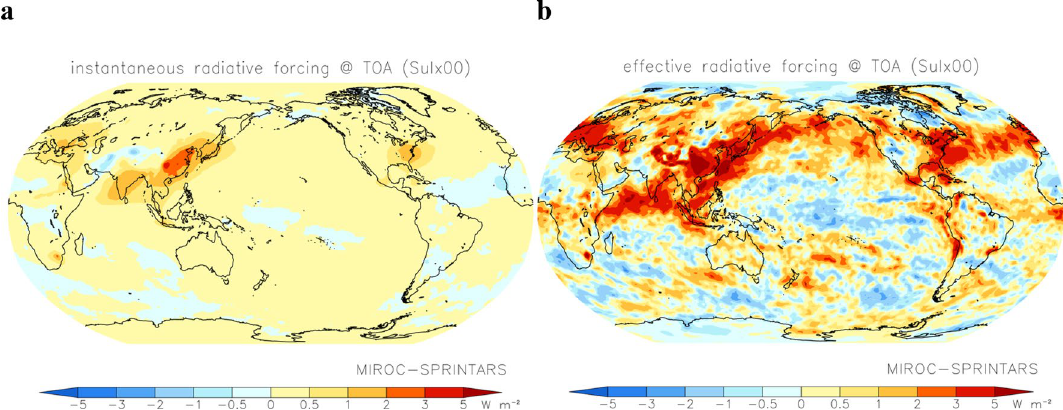
Figure 1. Global distribution of radiative forcing with reduced sulphate aerosols. Distribution of the annual mean instantaneous ( a ) and effective ( b ) radiative forcing if fuel SO 2 emissions are reduced to zero simulated by the MIROC–SPRINTARS. The maps were generated with GrADS 2.2.1 (http://cola.gmu.edu/grads